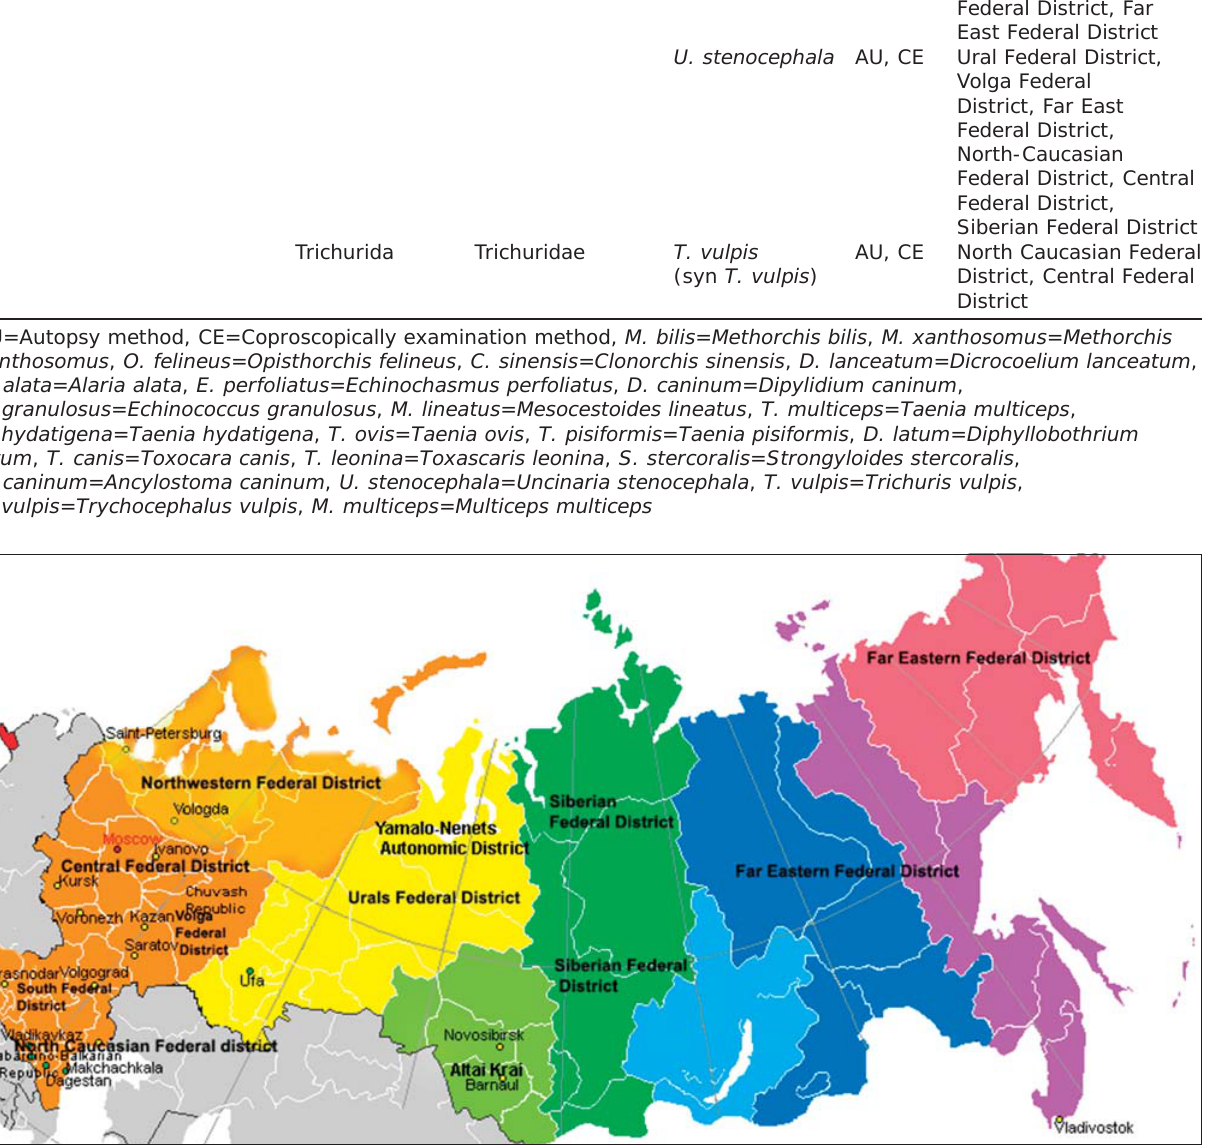
Figure-1: Map of researched